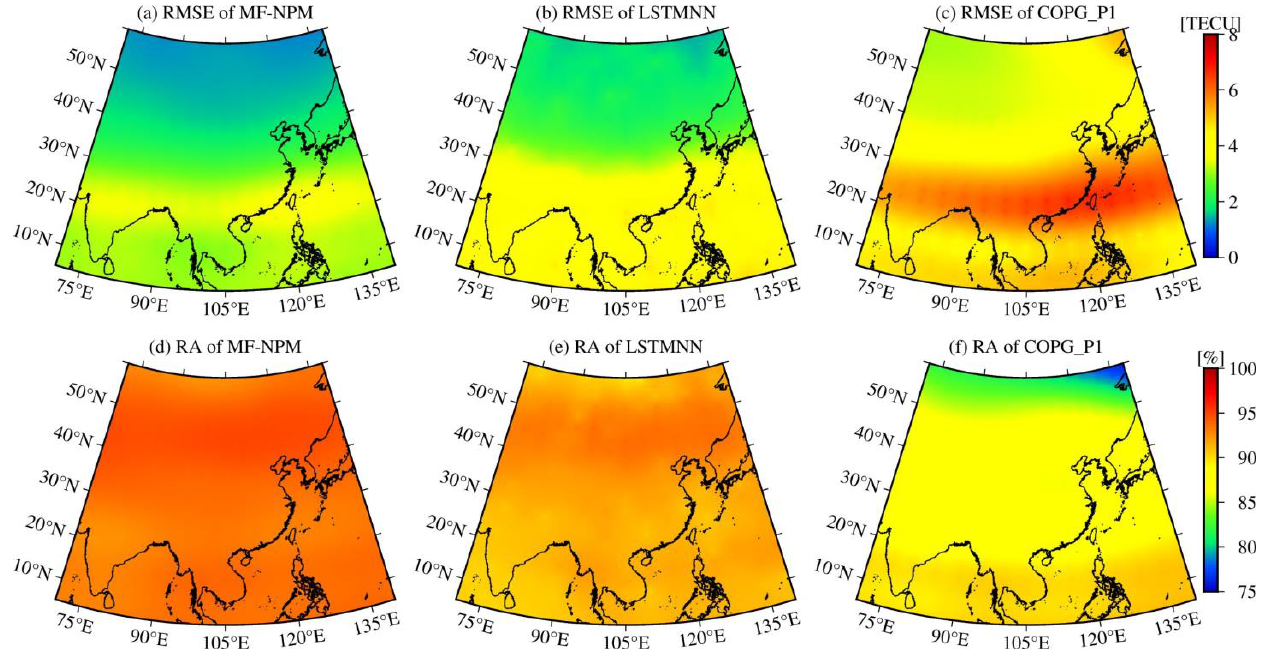
Figure 5. The 2D spatial distributions of ( a – c ) RMSE and ( d – f ) relative accuracy for MF-NPM, LSTMNN, and COPG in the peak year of solar activity (2014).